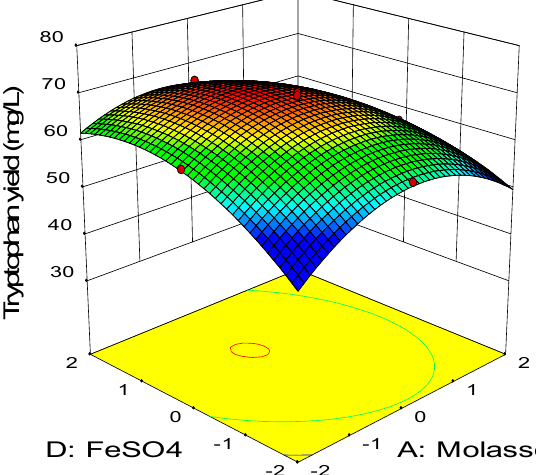
Figure 5. Response surface of tryptophan production by P. acidilactici TP-6 as a function of molasses and FeSO 4 .